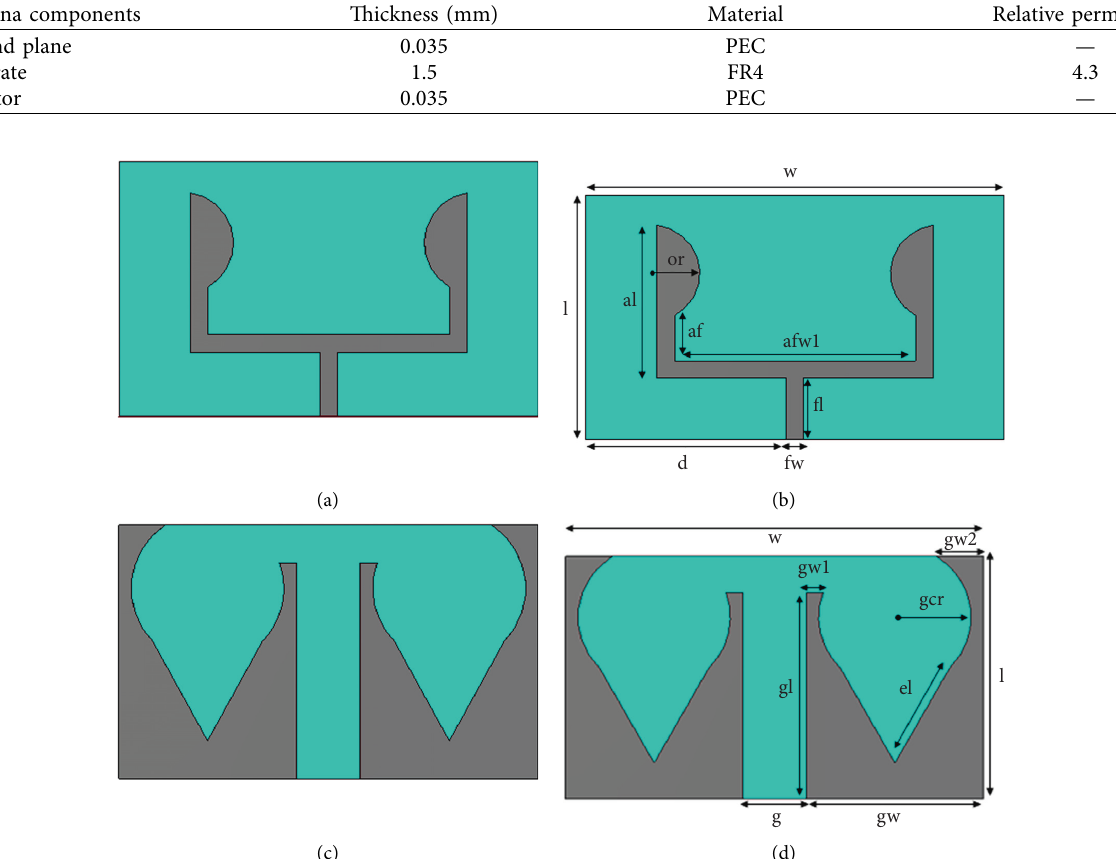
Figure 1: Array two (a, b) top view and (c, d) bottom view.(a) View from the top.(b) Top view (schematic diagram).(c) Back view.(d) Back view (schematic diagram). Table 2: Array parameter two dimensions. S.